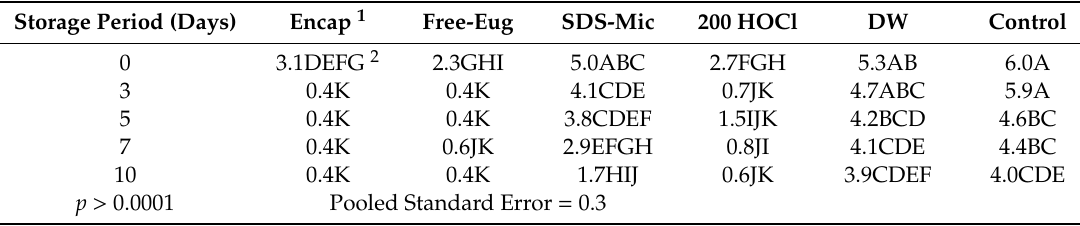
Table 2. Surviving Escherichia coli O157:H7 (log 10 CFU / cm 2 ) on spinach surfaces as a function of the interaction of antimicrobial treatment and days of aerobic storage at 5 ◦